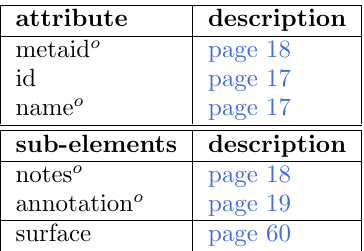
Listing 2.58 shows the use of the plot3D element in a SED-ML file as defined by the SED-ML Level 1 Version 2 XML